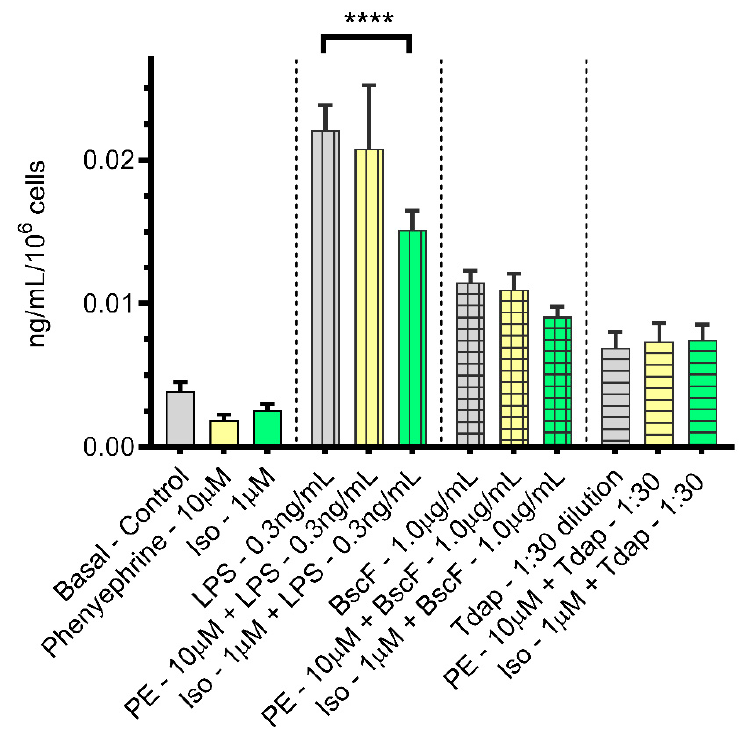
Figure 4. Both PE and ISO failed to significantly attenuate the expression of the prostanoids family member PGF2 α upregulated by LPS or B. pertussis antigens, BscF and Tdap, in THP-1 cells. THP-1 cells in serum-deprived RPMI media treated with PBS, PE alone (10.0 µM), and ISO alone (1.0 µM) as control treatments, LPS alone (0.3 ng/mL), BscF alone (1.0 µg/mL), and Tdap alone (1:30 dilution) as antigen stimulation and LPS+PE (0.3 ng/mL+10.0 µM)/LPS+ISO (0.3 ng/mL+1.0 µM), BscF+PE (1.0 µg/mL+10.0 µM)/BscF+ISO (1.0 µg/mL+1.0 µM), and Tdap+PE (1:30 dilution +10.0 µM)/Tdap+ISO